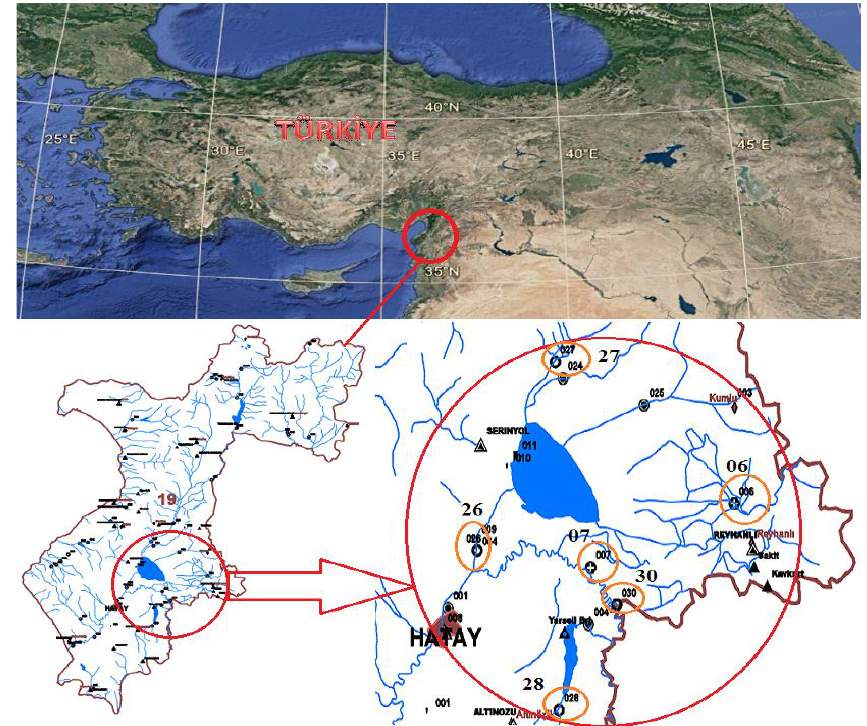
Figure 1. General location of the lower small Asi River sub-basin and streamflow gauge stations (SGSs) [33].